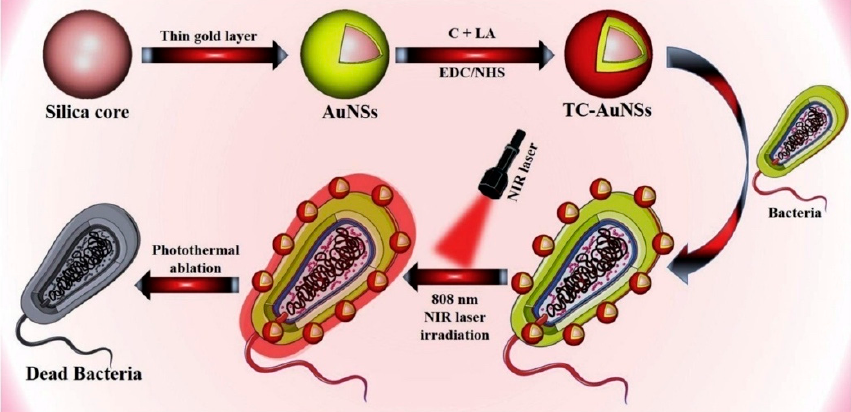
Figure 13. General representation of the photothermal mechanism for bacteria. Reproduced from [106], with permission from Elsevier, 2019.